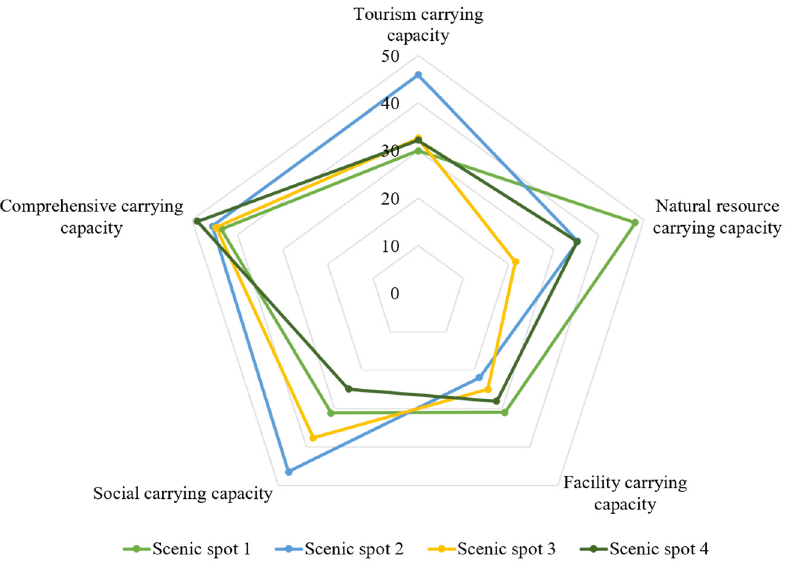
Figure 7. Comparison of the carrying capacity of scenic spots.